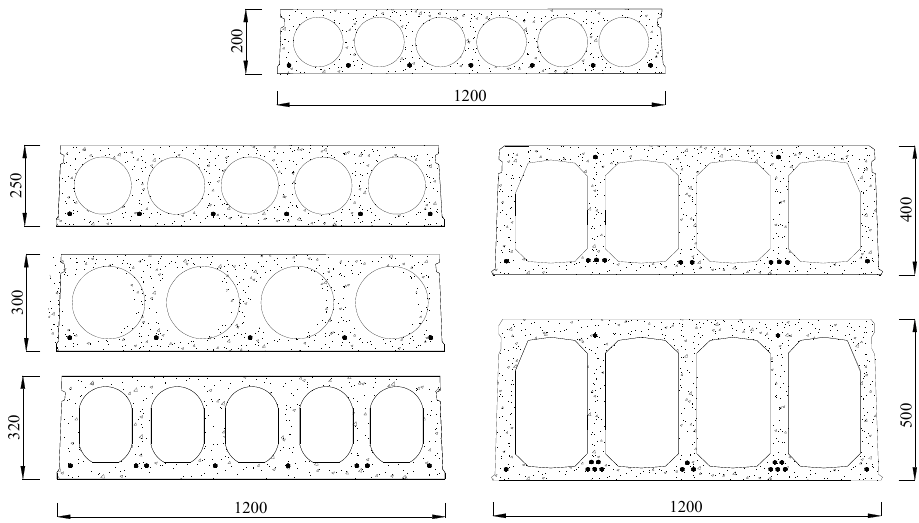
Figure 1. Typical HCS cross sections (all dimensions are in mm).